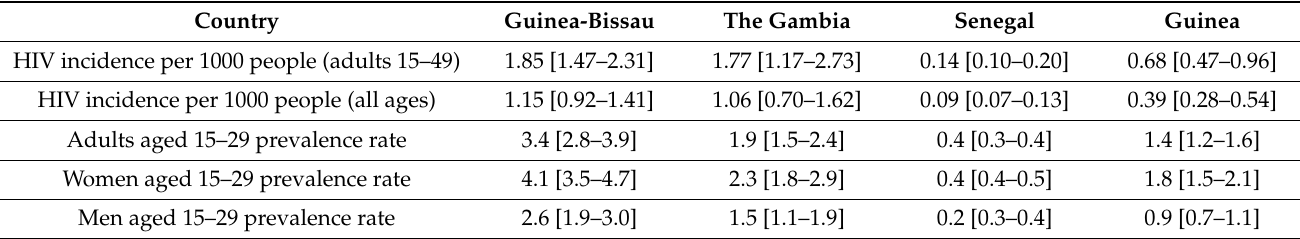
Table A1. Cross-country comparison of HIV/AIDS incidence and prevalence in Guinea-Bissau, The Gambia, Senegal, and Guinea (2019).